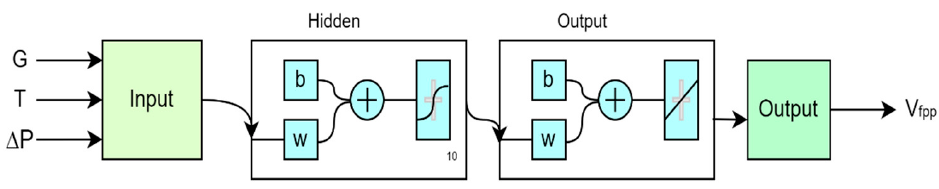
Figure 5. The neural network architecture.